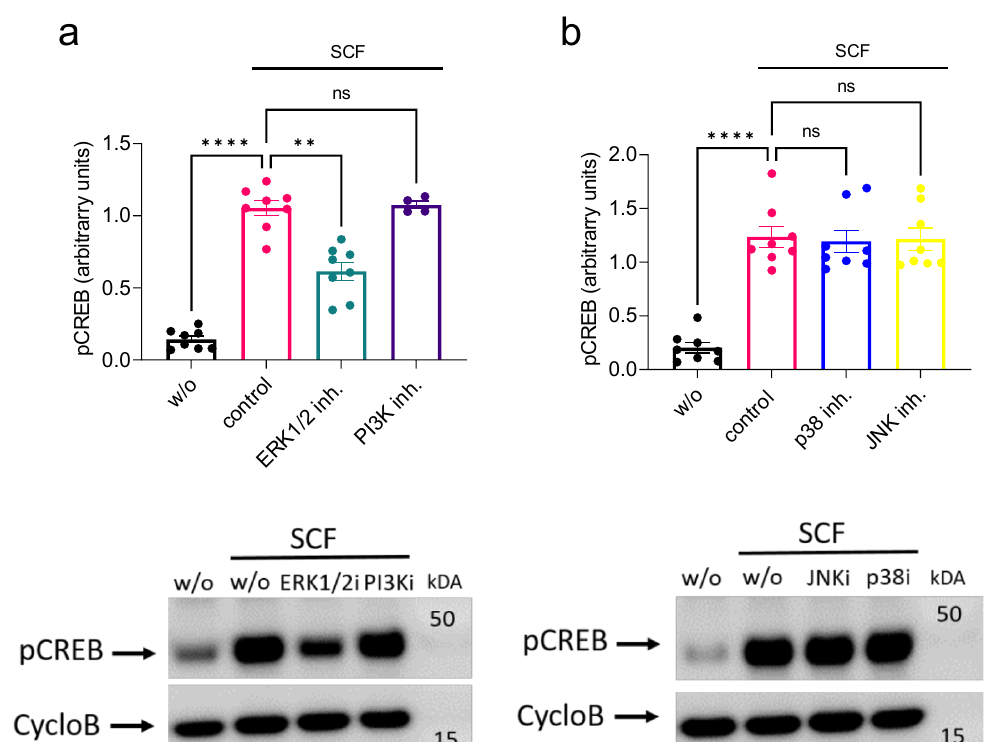
Figure 2. SCF-elicited CREB phosphorylation occurs in an ERK1/2-dependent manner. ( a ) SkMCs were pretreated with inhibitors of ERK1/2 and PI3K and stimulated with SCF for 15 min; phosphorylation of CREB was detected by immunoblot in whole-cell lysates. Upper panel: Image J based semi-quantification of the detected signal for pCREB normalized to the housekeeping protein Cyclophilin B (CycloB). Lower panel: Representative time-course. ( b ) As in ( a ), but inhibitors of p38 and JNK were used instead. Each dot corresponds to one experiment (individual MC culture). ** p < 0.01, **** p < 0.0001.